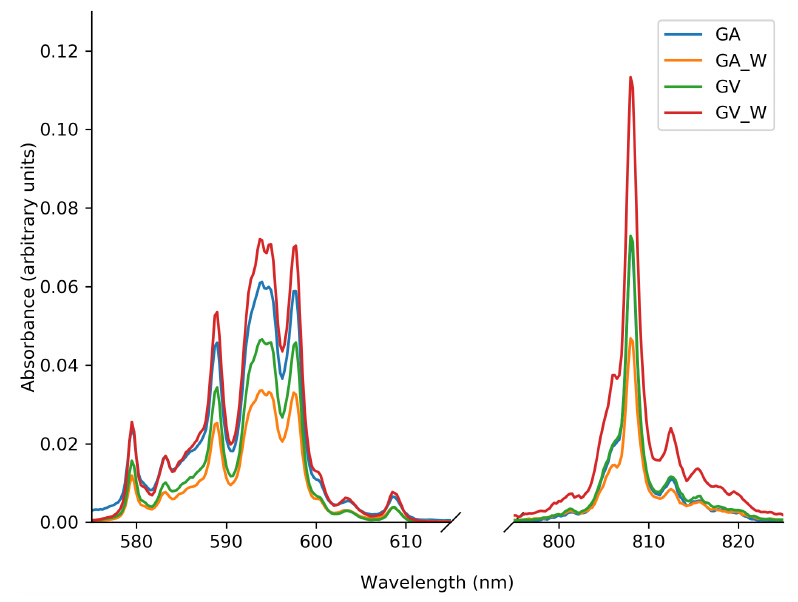
Figure 7. Detail of the Nd-related absorption features of Figure 6.